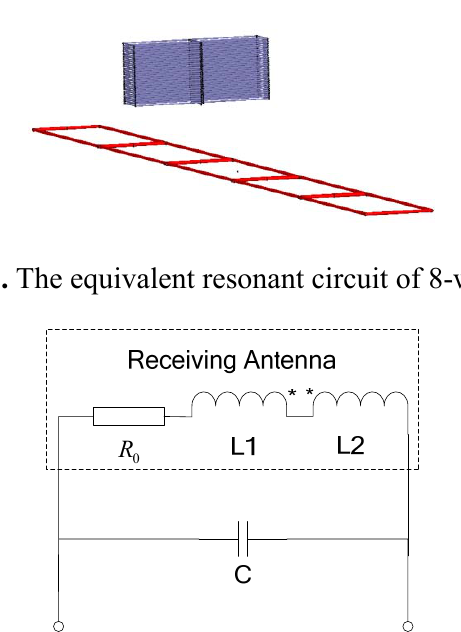
Figure 24. The relative position of 8-word coils and loop-cable.